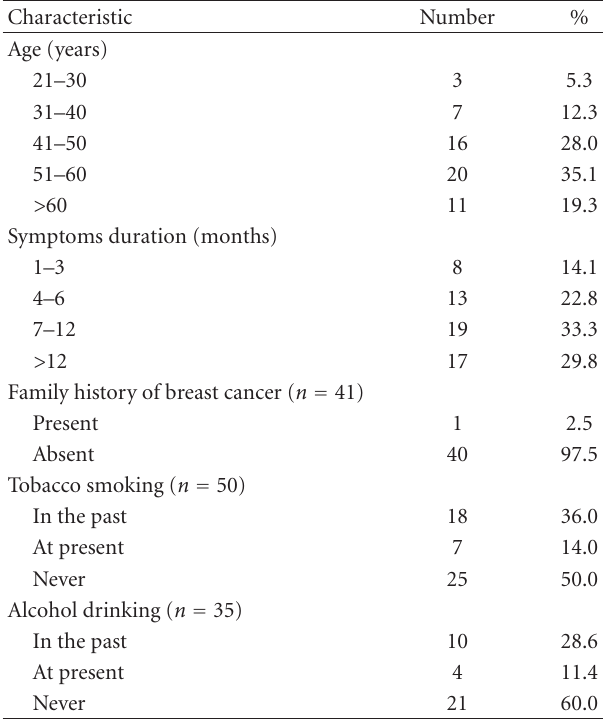
Table 1: Characteristics of 57 male patients with breast